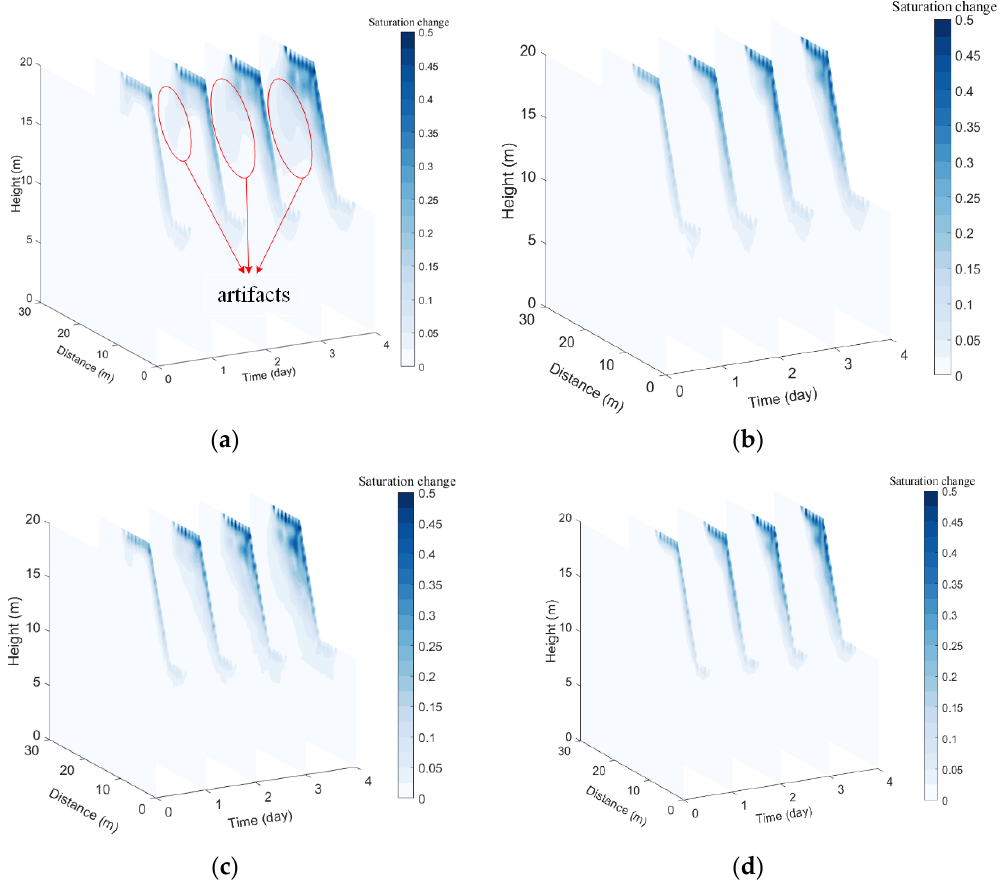
Figure 5. The spatial and temporal evolution of moisture obtained by inversion of various arrays without noise: ( a ) Pole-Pole array; ( b ) Pole-Dipole array; ( c ) Wenner array; ( d ) Dipole-Dipole array. Table 3. The FOS obtained by the proposed framework in the noiseless scenario of multiple arrays.